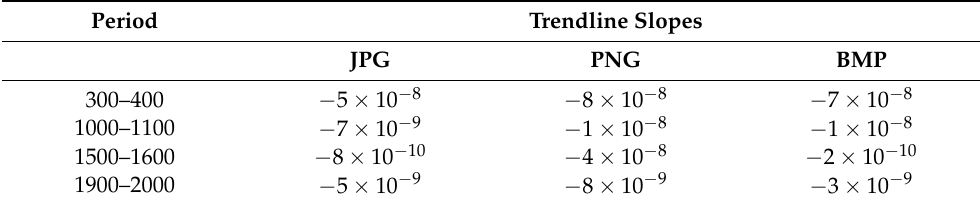
Figure 6. Loss graph of L-VGG-JPG, L-VGG-PNG and L-VGG-BMP phase I-IV ( a – d ), respectively. Table 3. Slopes of trendlines in four training phases.